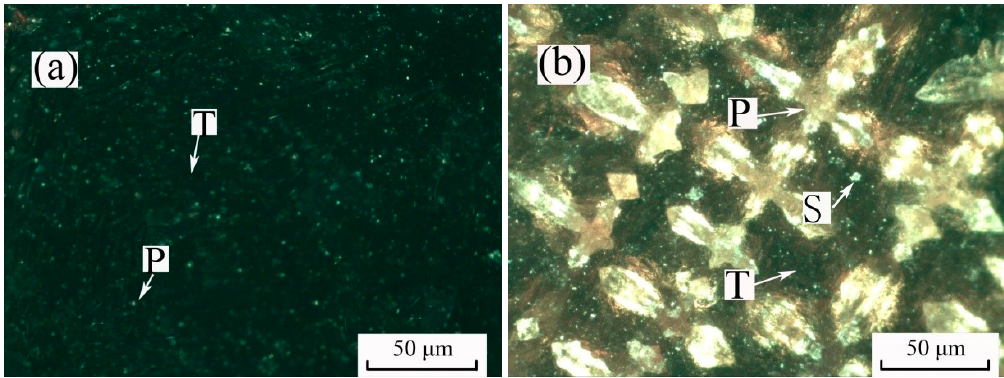
Figure 1. Optical micrographs of the original ( a ) and modified ( b ) slag (P: perovskite, T: titanaugite, S: magnesium aluminate spinel (MA-spinel)).